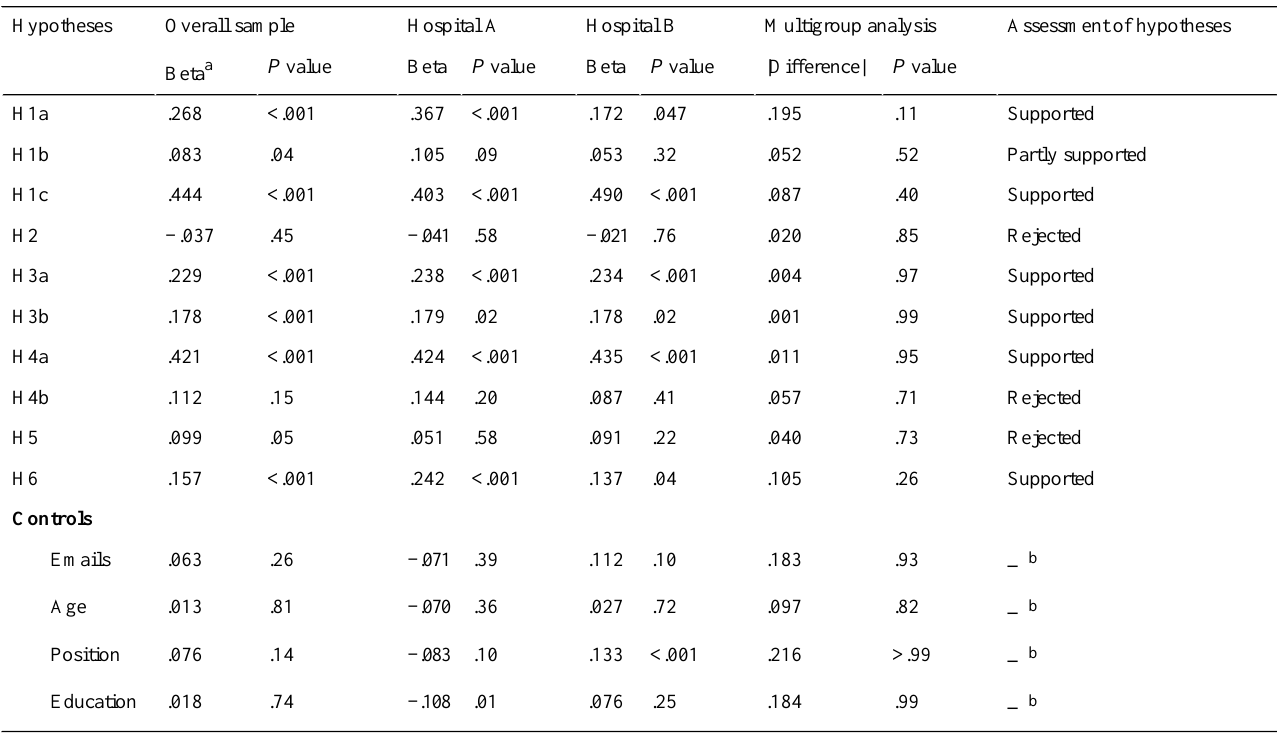
Table 6. Results of structural equation model and its multi-group